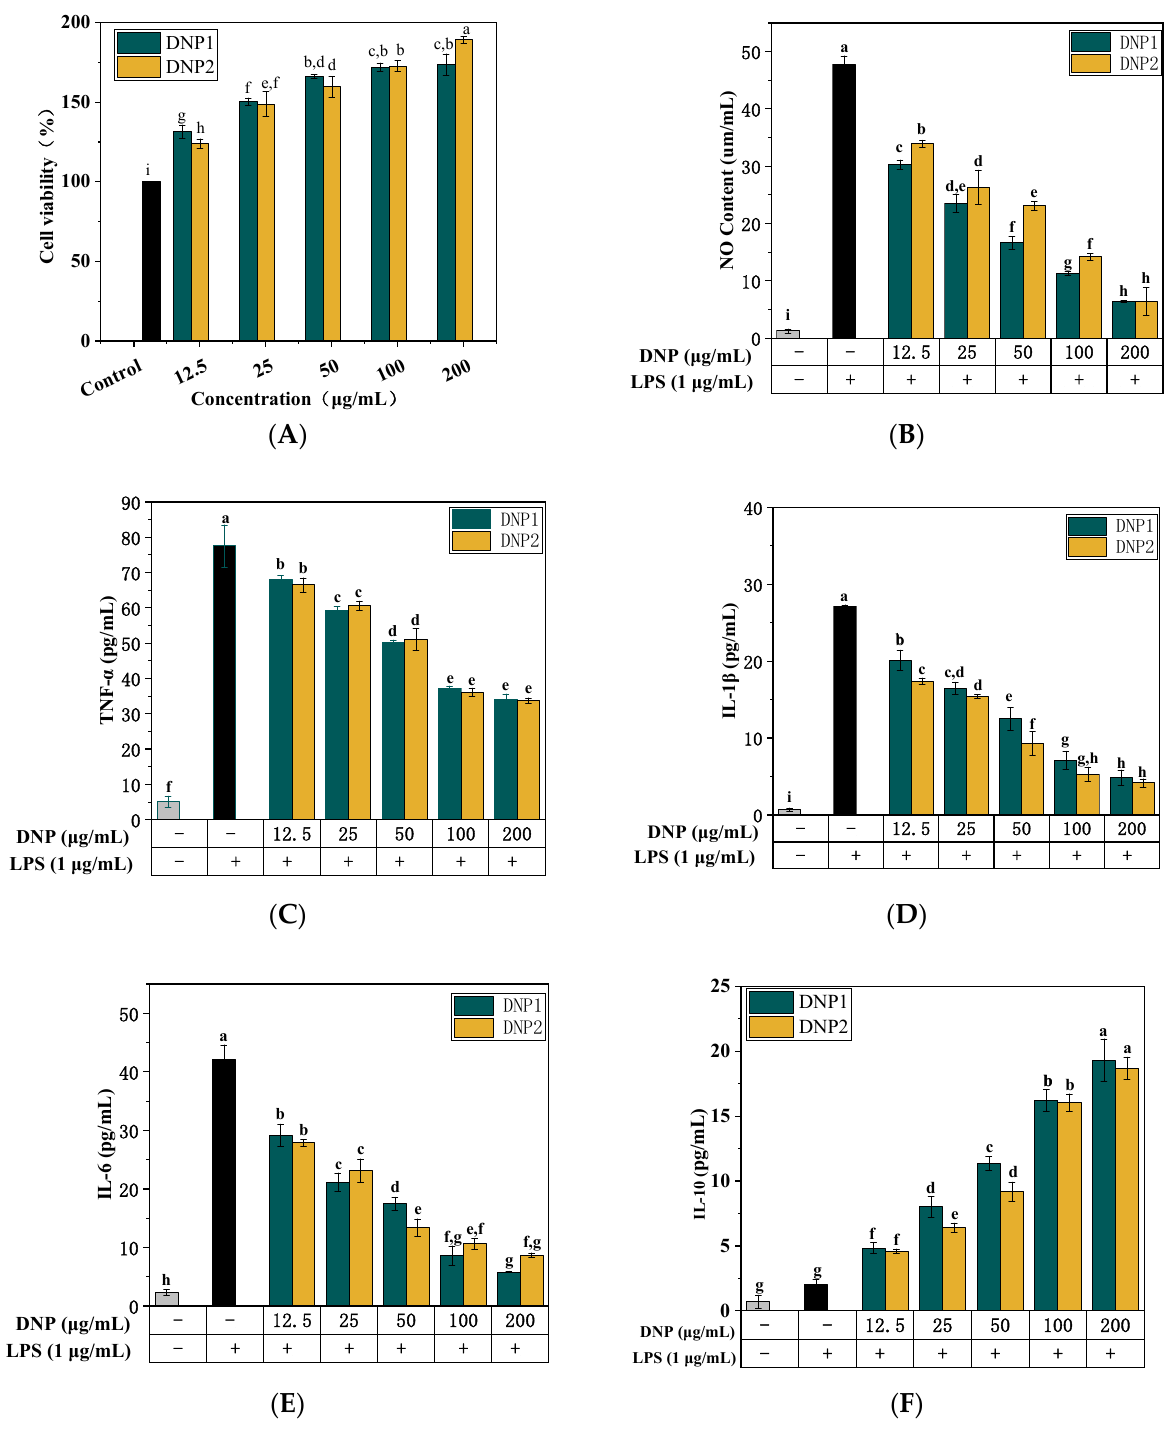
Figure 5. Effect of DNPs on the proliferation of RAW 264.7 macrophages ( A ); Effect of DNPs on the content of NO and cytokines by RAW 264.7 macrophages, ( B ) NO, ( C ) TNF- α , ( D ) IL-1 β , ( E ) IL-6, and ( F ) IL-10. Different lowercase above the columns indicating significant differences among groups ( p < 0.05).